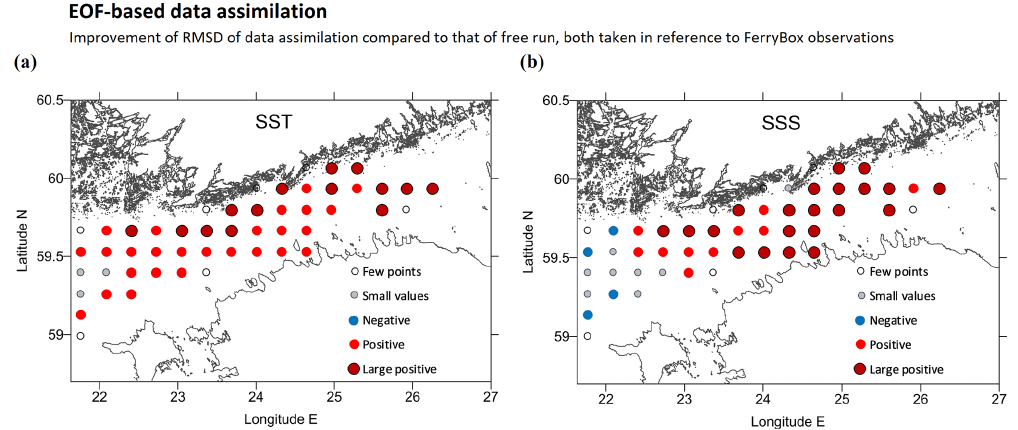
Figure 9. Improvement of RMSD of DA compared to that of FR, both taken in reference to 110000 FerryBox observations. Comparison is made for 20 × 20 grid cells (about 10 nautical miles) for SST (a) and SSS (b) over the whole study period. Legend codes: few points – less than 100 observations in a box, small values – absolute percentage change less than 10%, negative – DA RMSD growth more than 10%, positive – DA improvement (RMSD reduction) from 10% to 30%, large positive – improvement more than